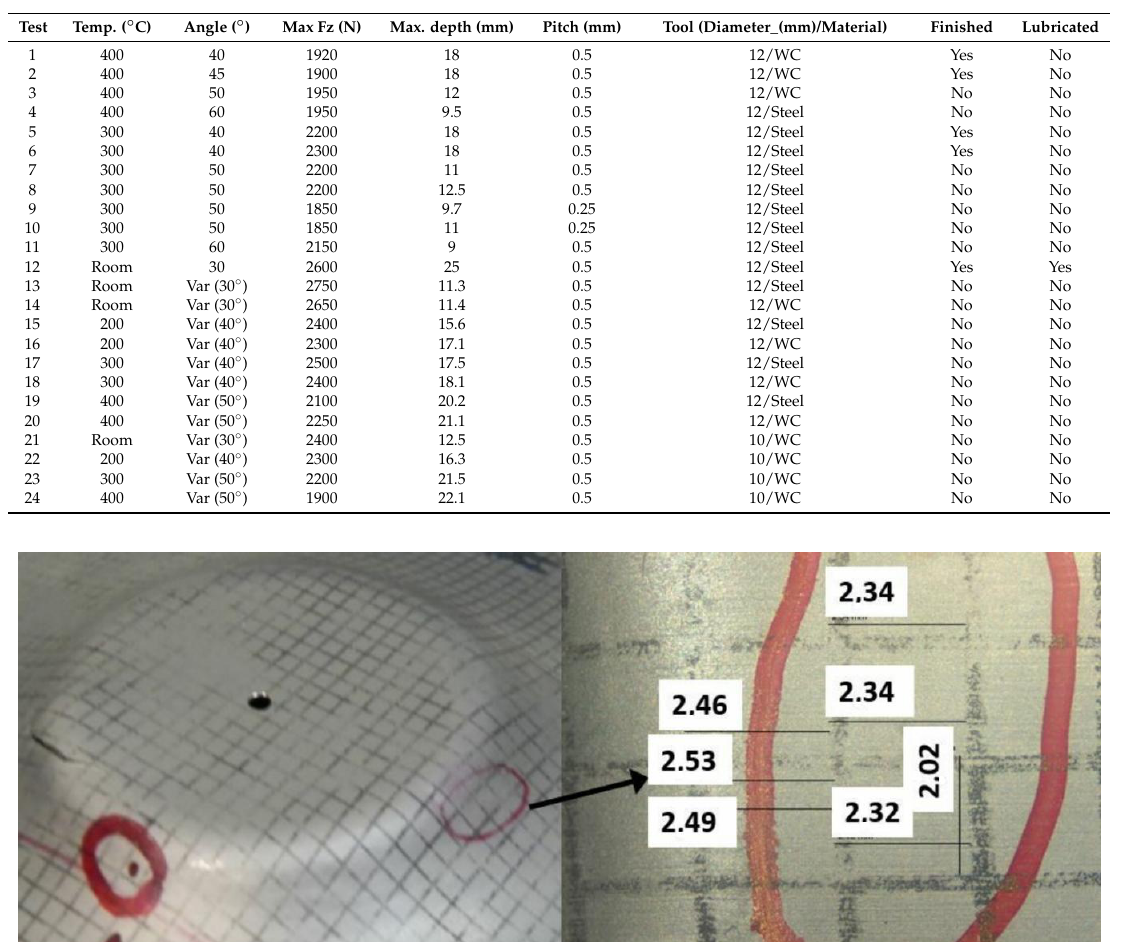
Table 2. Single Point Incremental Forming tests of truncated cones with constant and variable wall angles. The angle in brackets establishes the maximum value angle with no breaking during the test in variable wall angle tests.